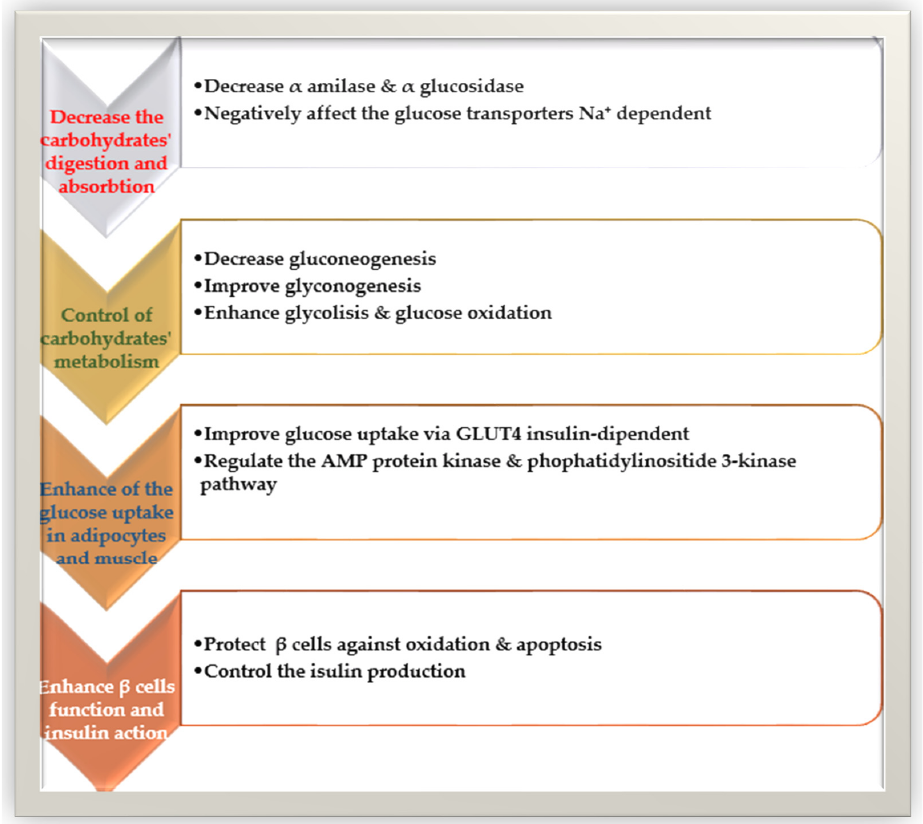
Figure 3. The polyphenols’ effects on glucose homeostasis and insulin resistance.